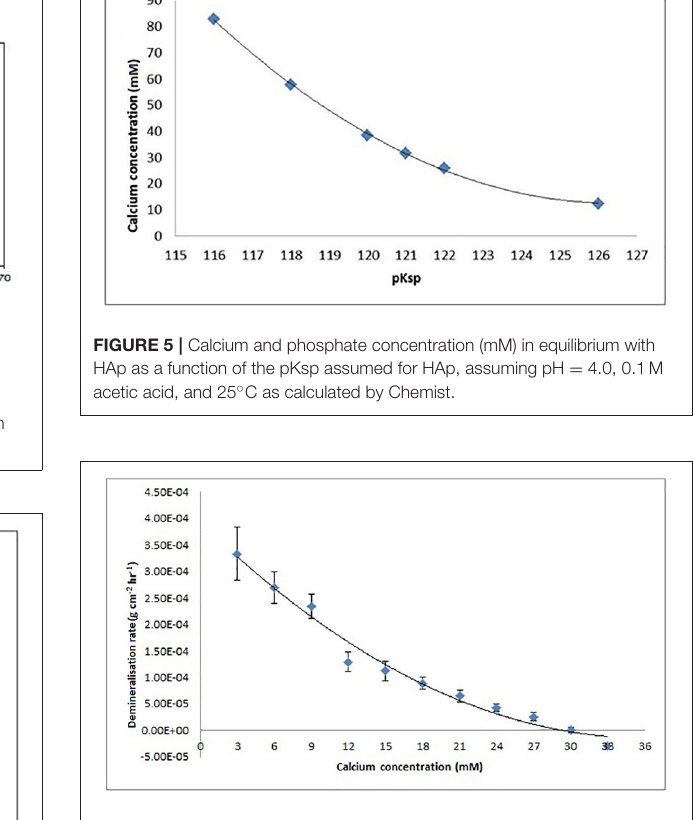
FIGURE 6 | Enamel demineralization rate as a function of increasing calcium concentration at pH = 4.0 and 25 ◦ C based on results from the SMR experiment. Rate is zero at a calcium concentration of 30mM calculated using MATLAB from the x-intercept of the regression curve ( R 2 = 9.8). 10 − 06 to ± 1.09 × 10 − 05 ). This result shows that under